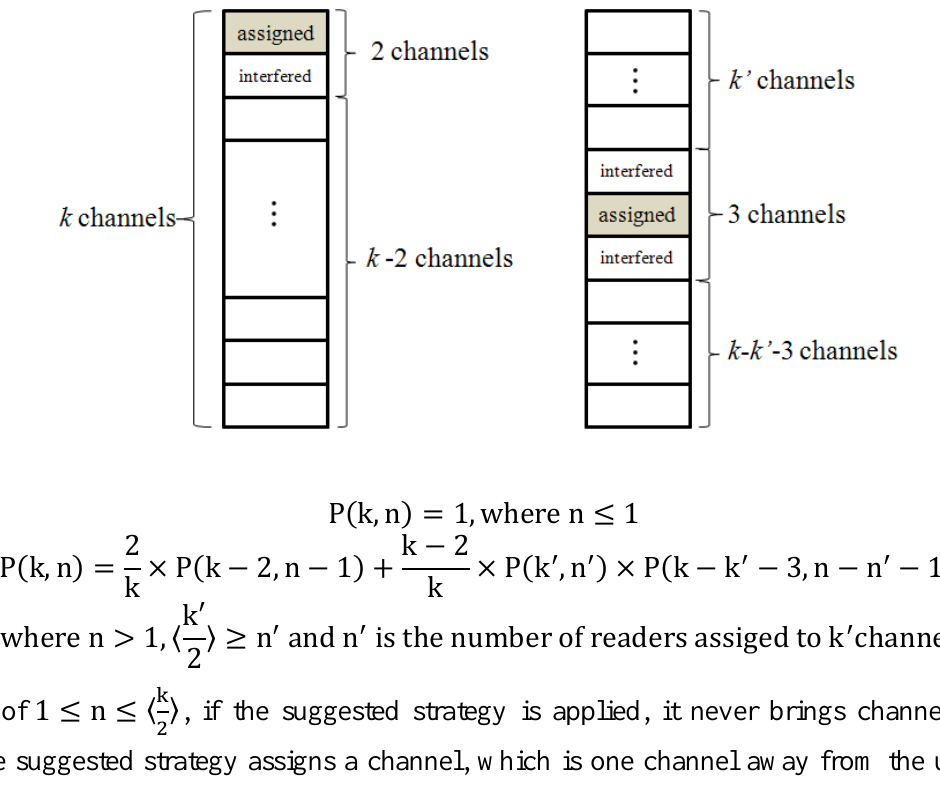
Figure 5. Random channel